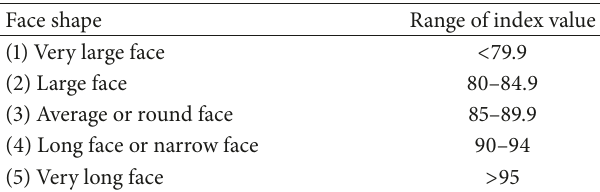
Table 2: Facial forms (Yesmin et al., 2014). Table 3: Method error calculation using Dahlberg’s